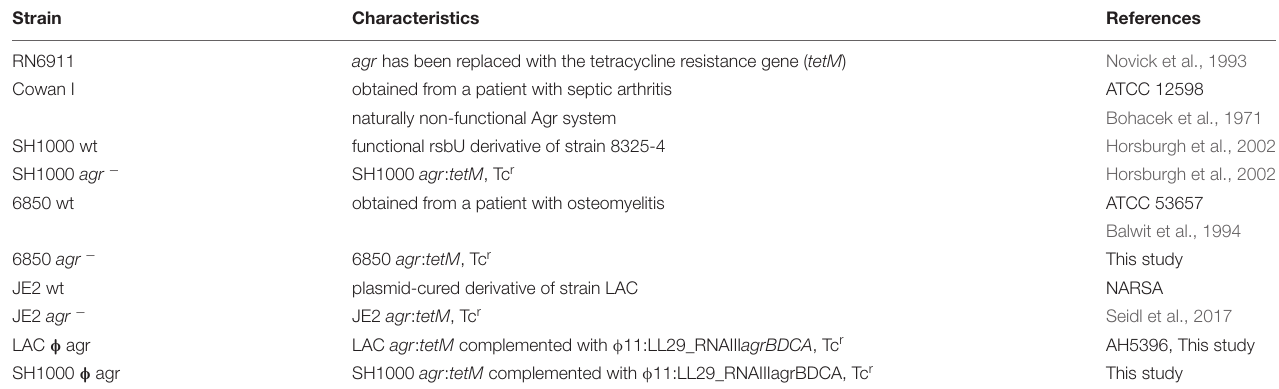
TABLE 1 | S. aureus wild type and agr mutant strains used in this study.